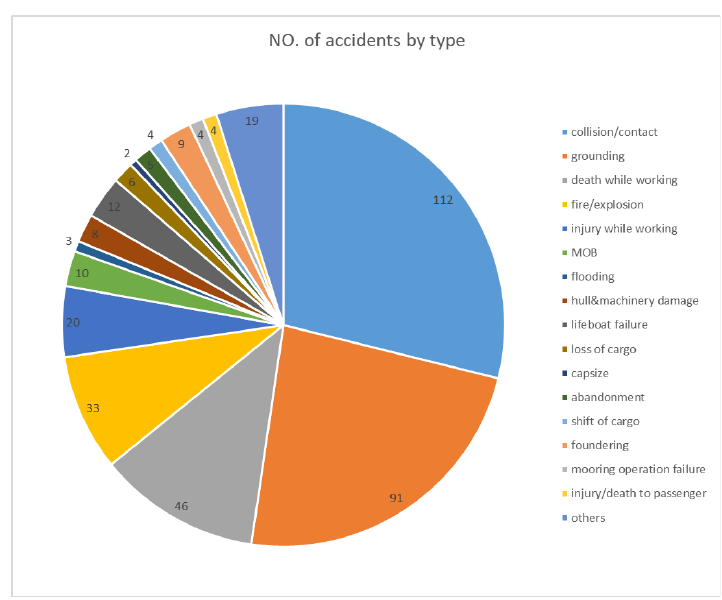
Figure 4. Number of accidents by